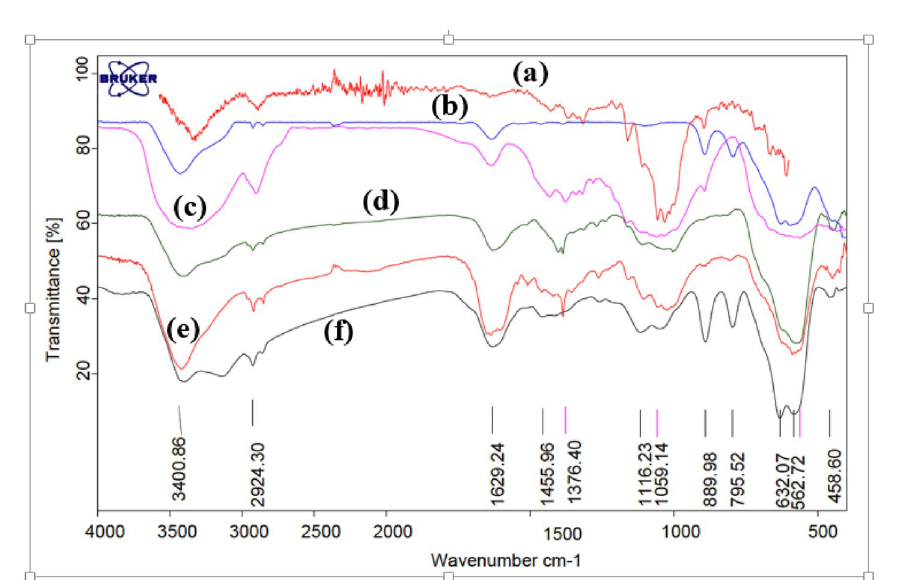
Figure 2. FT-IR spectra of ( a ) almondshell, ( b ) Fe 3 O 4 , ( c ) Fe 3 O 4 @nano-almondshell, ( d ) Fe 3 O 4 @nano-